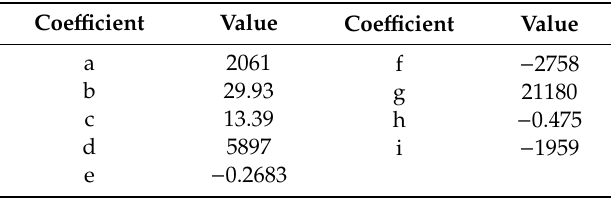
Table 4. Results of estimation of function coefficients in eqs. 9–11.